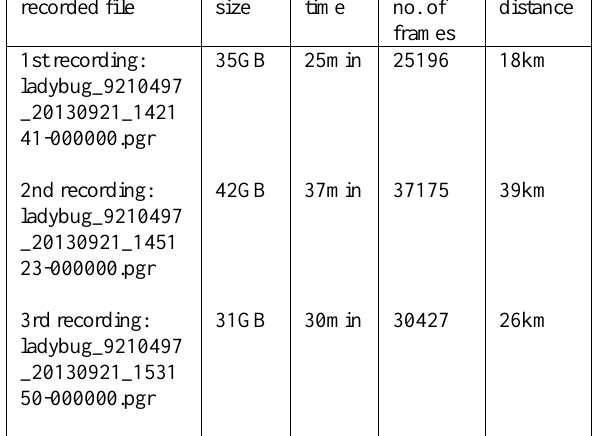
Table 2. Statistics of the recordings in the district of Czarny